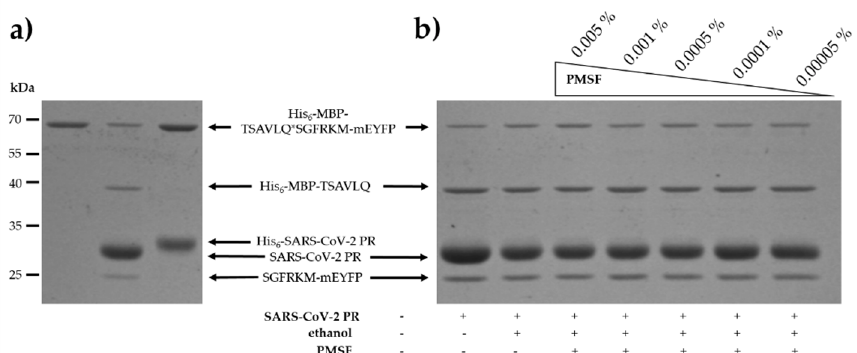
Figure 6. E ff ect of N-terminal His 6 tag and PMSF on SARS-CoV-2 3CLpro activity. ( a ) In cleavage reactions we used His 6 -MBP-TSAVLQ*SGFRKM-mEYFP as a substrate of His 6 -tagged and untagged forms of SARS-CoV-2 3CLpro. ( b ) The e ff ect of PMSF on the cleavage of His 6 -MBP-TSAVLQ*SGFRKM- mEYFP was studied, using untagged protease. PMSF was dissolved in ethanol and was applied in 0.005–0.00005% ( m / v ) concentration range. Uncleaved substrate is shown in figure part ( a ). Gel images are representatives of ≥ 2 parallel